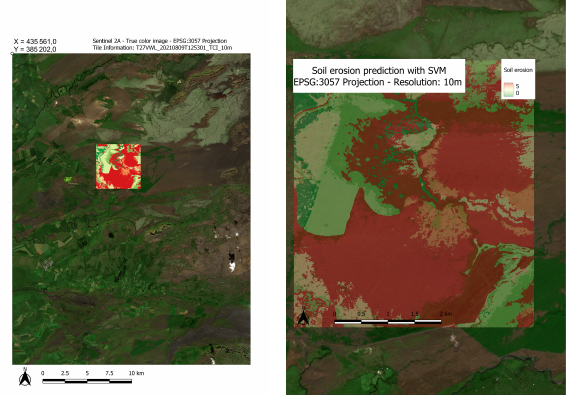
Figure 2. Soil erosion prediction with SVM EPSG:3057 projection over true color